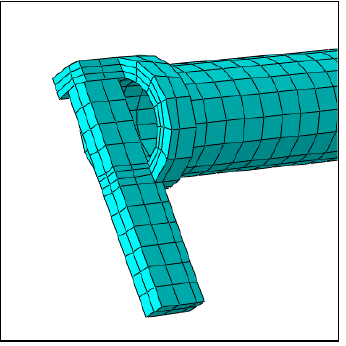
Figure 5. Socket model on the horizontal bar.